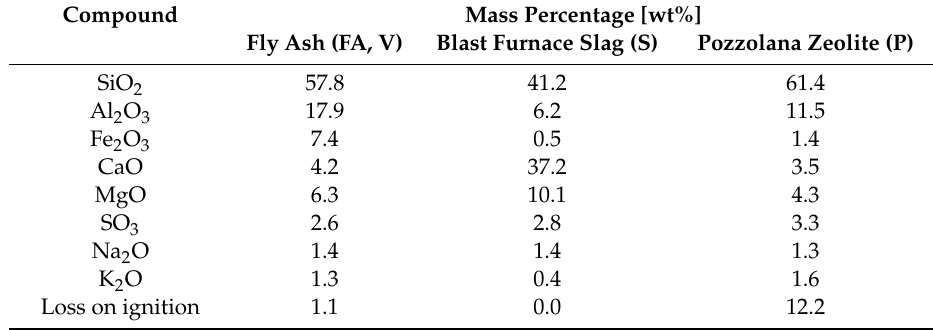
Table 1. Chemical properties of cementitious constituents of (3) CEM V / A (S-V) 32.5 R and (4) CEM V / B (S-P) 32.5.